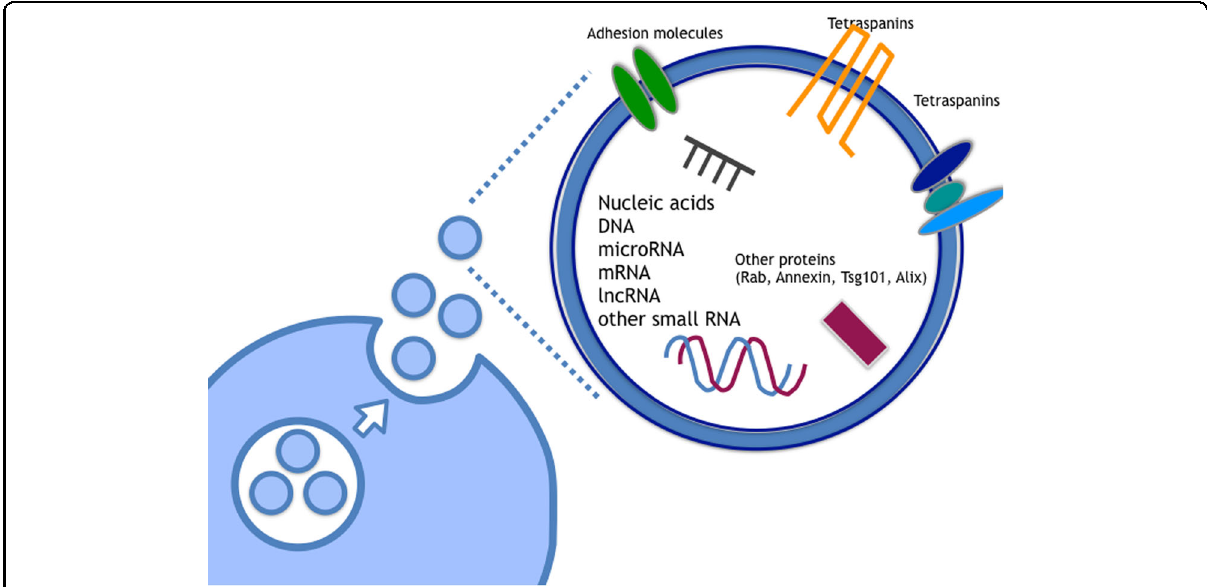
Fig. 2 Components of EVs. In EVs, various types of RNAs, such as small noncoding RNA, long noncoding RNA, and coding RNA and DNA are included. Proteins are also contained in EVs and on EV lipid